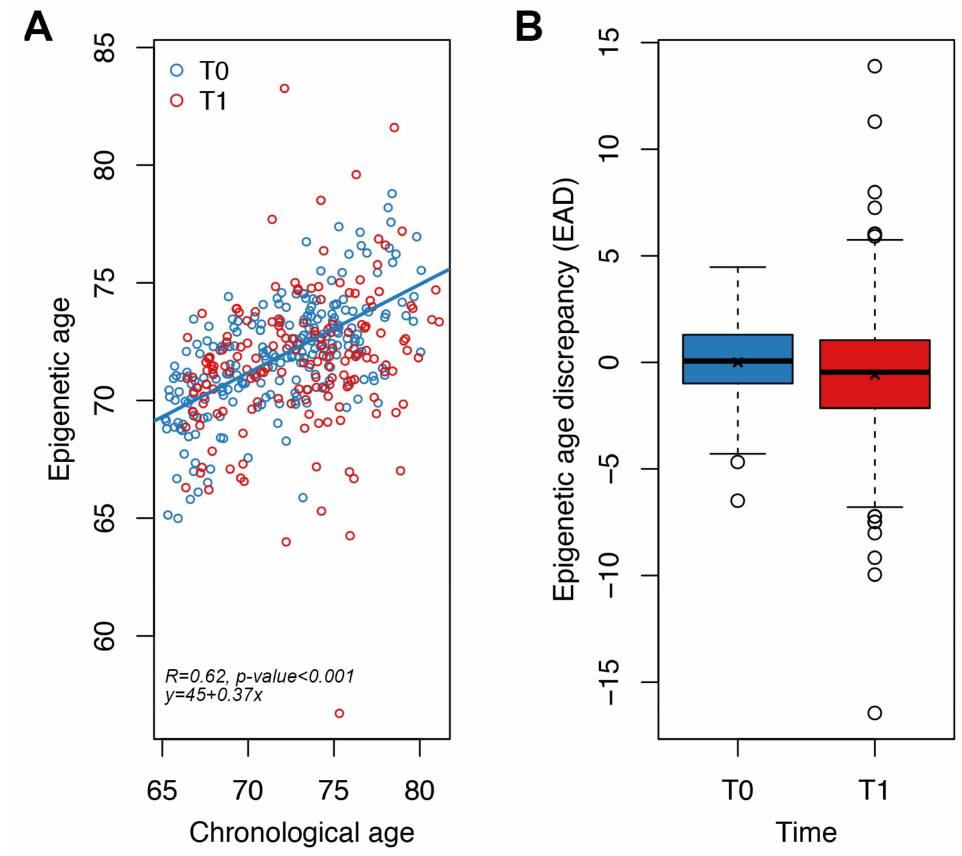
Figure 4. Application of the targeted epigenetic clock to an independent validation dataset. Each dot represents a subject. ( A ) Epigenetic age ( y -axis) vs. chronological age ( x -axis) in NU-AGE subjects at T0 and T1. Spearman correlation coefficient and the equation of the regression line are reported. ( B ) Boxplots of epigenetic age discrepancy (EAD) values at T0 and T1; mean is indicated by the x